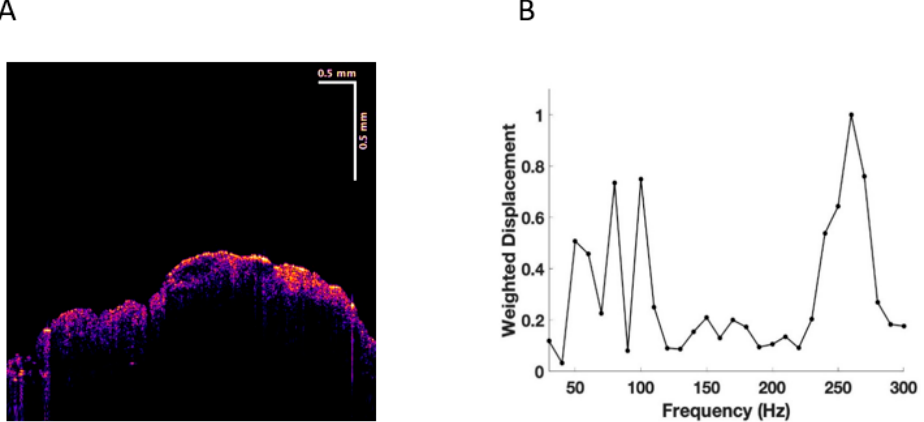
Figure 2. ( A ) Color-coded OCT image of a nodular basal cell carcinoma (BCC) showing the thin epidermis (yellow and pink) and the papillary dermis in blue. Note: the black oval spots are the location of the lesions. ( B ) Plot of weighted displacement versus frequency for BCC showing the new cellular (80 Hz), papillary collagen fibers (100–120 Hz), and new large fibrotic peak (250–260 Hz).